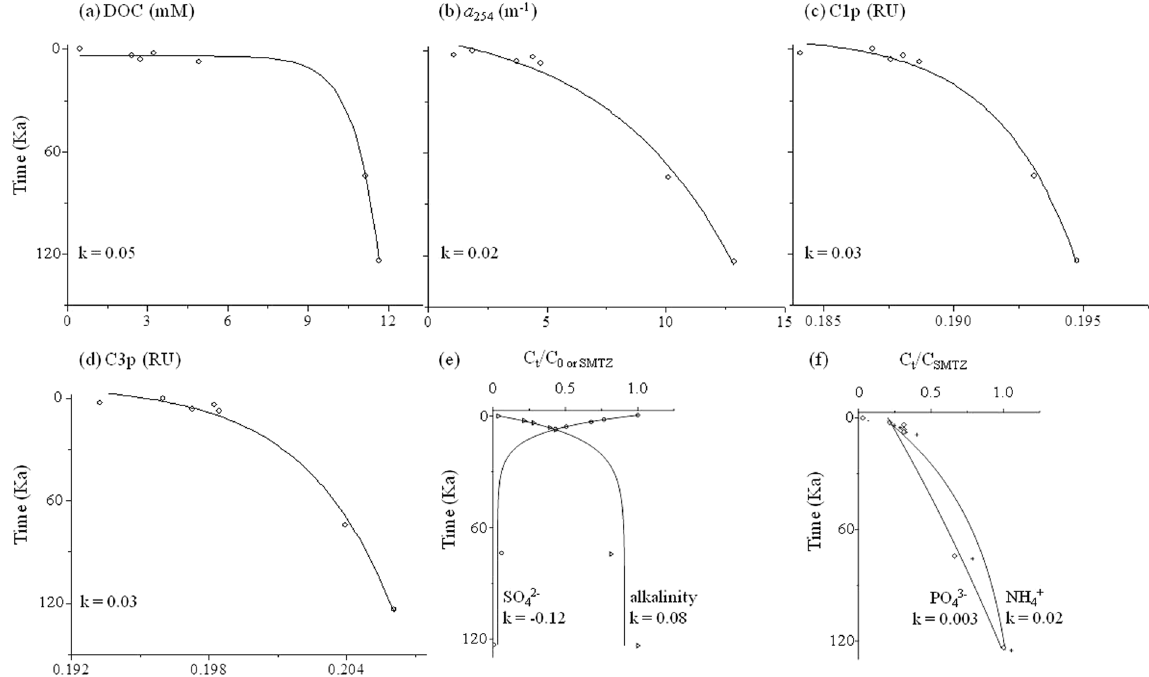
Figure 3. Examples of first order kinetics exponential production of DOC, CDOM, and FDOM above the SMTZ (~21 mbsf) in pore waters at site U1 (R 2 ≥ 0.98) concurrent with the production (R 2 ≥ 0.89) of alkalinity and nutrients (PO 43 − and NH 4 + ) and the reduction (R 2 = 1.00) of sulfate (SO 42 − ) ( p < 0.0001). Rate constant k unit: Kyr − 1